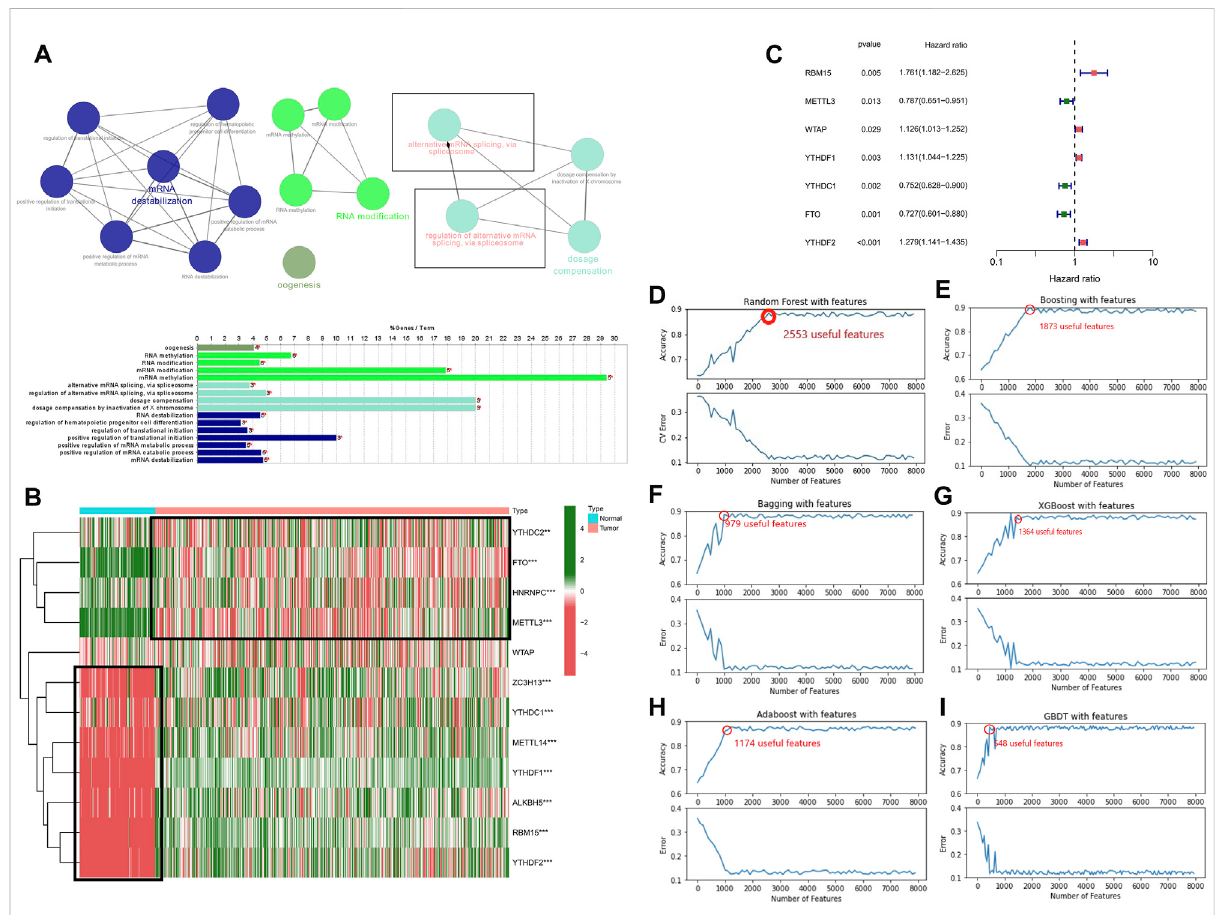
FIGURE 1 Relationship between the methylation status of the m6A RNA modulatory genes and the prognosis of patients with LGG (A) The GO terms and KEGG enrichment pathways analyses of the m6A modulator genes; the various colors re fl ect the various pathways. (B) In LGG, 12 m6A RNA- methylated regulator genes exhibit differential expression (C) The forest plot representing the analytical data for the univariate Cox regression. The 12 m6A RNA methylation modulators in LGG examined by means of univariate Cox regression and visualized by a forest plot. (D – I) Six algorithms applied to screen the potential AS. The number of features with the maximum accuracy and least margin of error after fi vefold cross- validation in “ Boosting ” , “ Bagging ” , “ XGBoost ” , “ Adaboost ” , “ GBDT ” , and “ Randomforest ” . *** p < 0.001, ** p < 0.01, and * p <